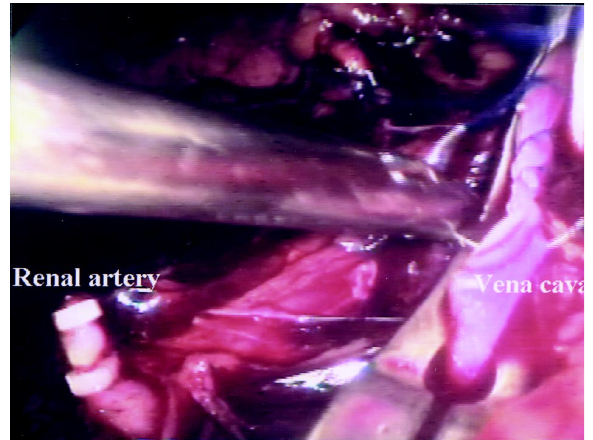
Figure 3 – Laparoscopic continuous running suture using 4-0 prolene.